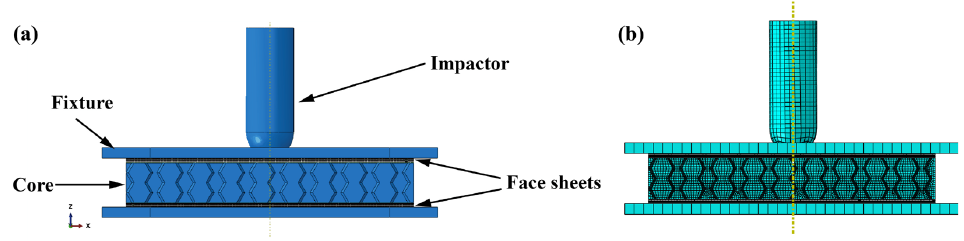
Figure 5. The finite element model. ( a ) 3D model, ( b ) model with mesh.